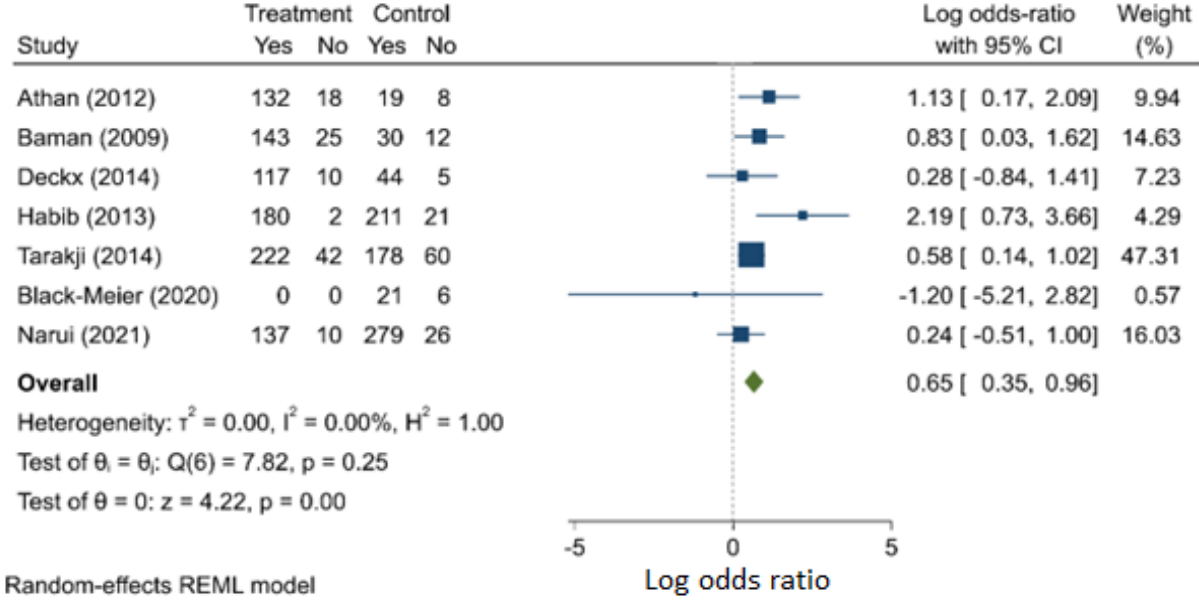
Figure 4. Heart failure as a risk factor for mortality.